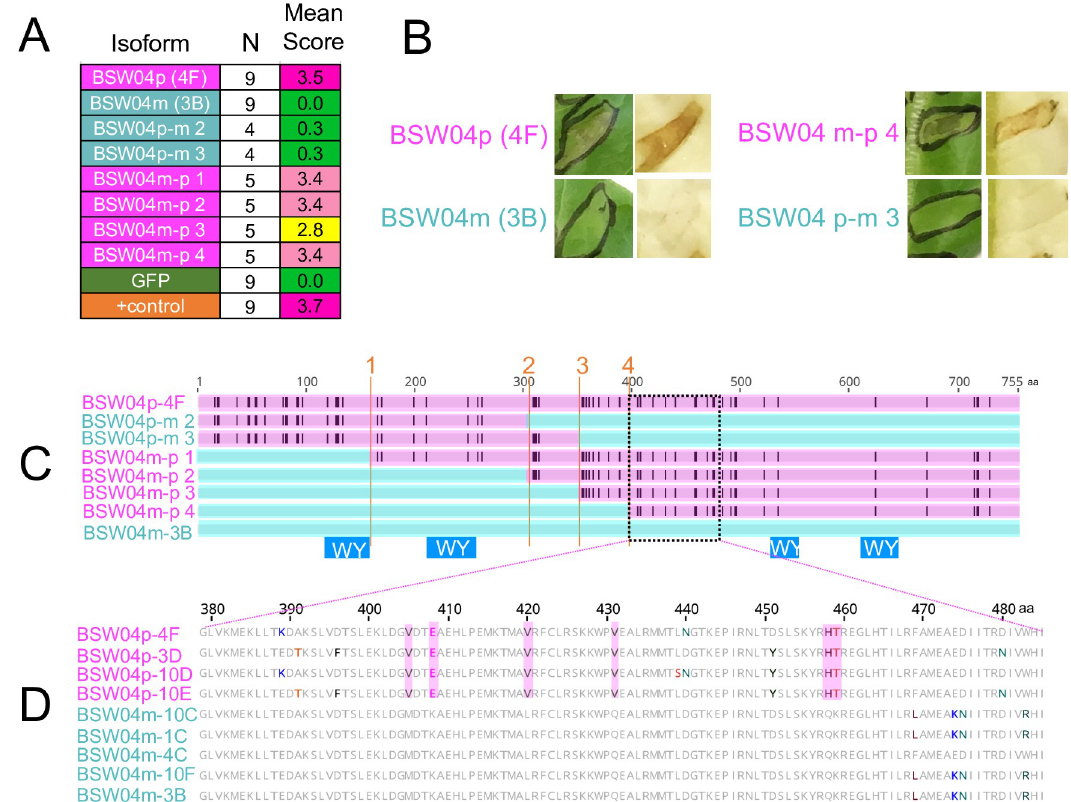
Fig 10. (A) Agroinfiltration scores for the BSW04 paralogs and domain swaps. One leaf per plant was infiltrated and scores were averaged across N replicates. Scoring and color scheme as in Fig 7. (B) Example agroinfiltration results from BSW04m-BSW04p domain swaps. Infiltrations were done in L . sativa cv. Ninja and scored 5 days post infiltration. (C) Sequence alignment of BSW04m, BSW04p, and the domain swaps. Black lines on sequence alignment indicate amino acid differences from BSW04m. Orange lines indicate recombination breakpoints used in generating the domain swaps. Blue squares show the predicted WY domains. Proteins with sequences that cause necrosis on Ninja are colored magenta; those that do not are colored aqua. (D) Sequence alignment of the putative recognized region of BSW04p for recognized and unrecognized clones of BSW04 .